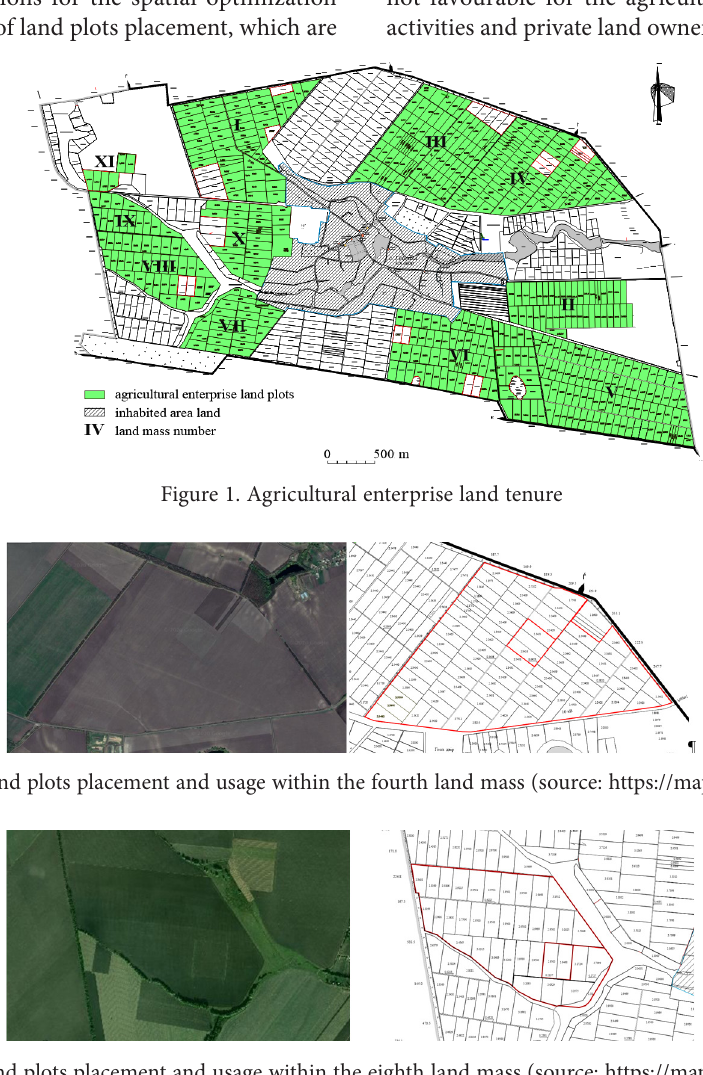
Figure 3. Land plots placement and usage within the eighth land mass (source: https://map.land.gov.ua/)